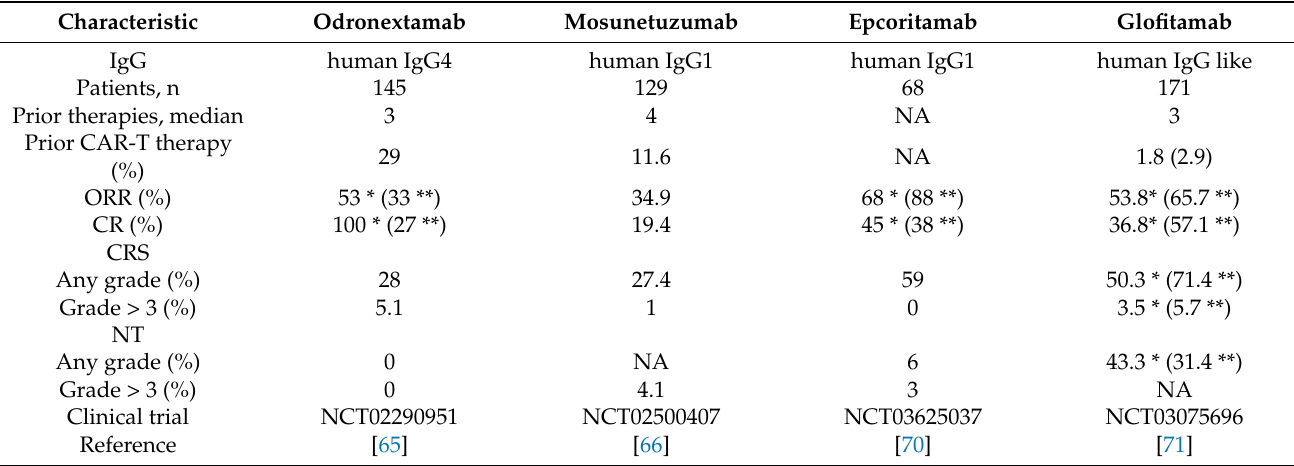
Table 1. CD20/CD3 BiTE therapy for relapsed or refractory